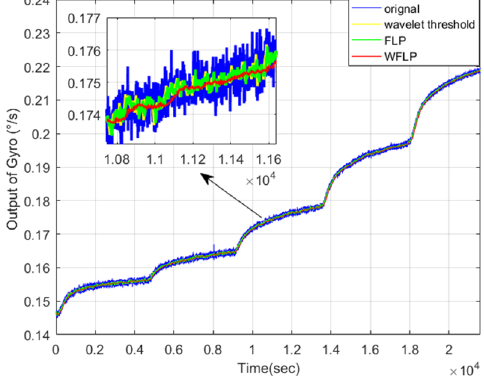
Figure 15. Reconstructed signal after denoising.